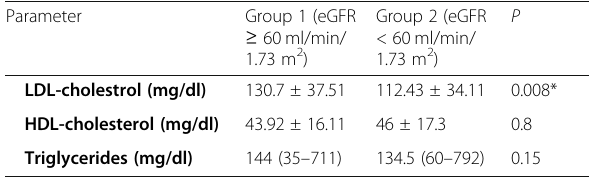
Table 2 Characteristics of the cohort compared according to eGFR levels (Continued)